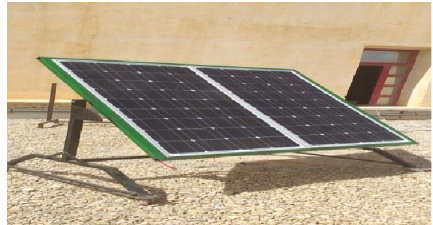
Figure 9: Electrical measurement of the tree and fi xed panels.